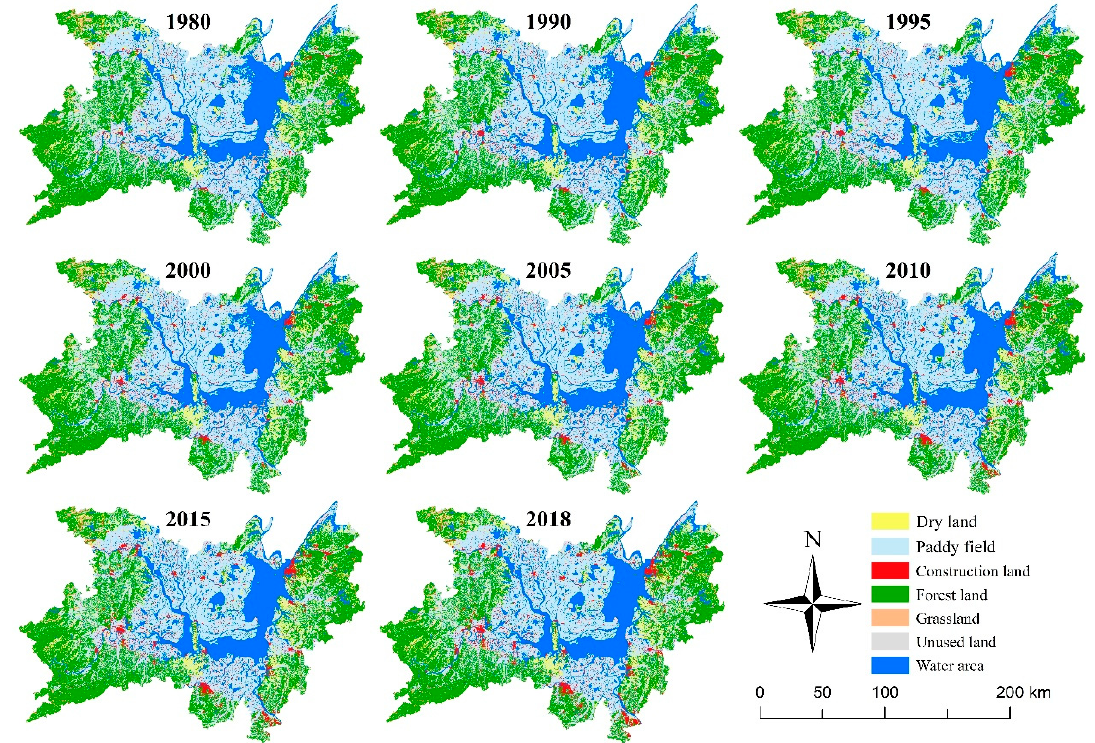
Figure 2. Landscape types of Dongting Lake Basin.